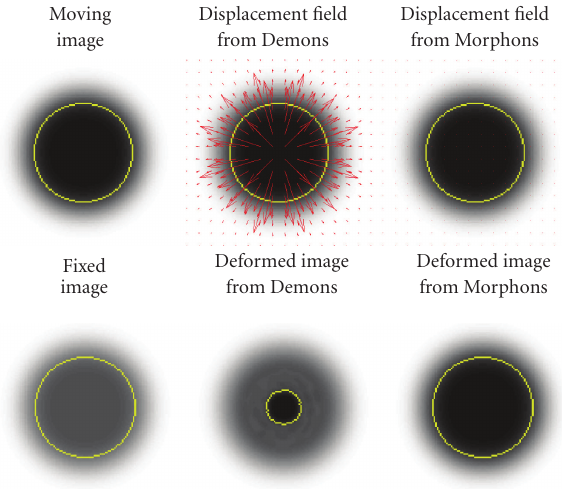
Figure 4: Results of the registration between 2 identical-sized blurred disks with di ff erent contrasts, using Demons and Mor- phons. In yellow: the contour of the disk. In red: the vector field resulting from the registration. The displacement field resulting from Morphons was very close to zero. Notice that the SSD is actually lower using Demons than Morphons. However, the SSD does not reflect the matching of the shapes, in opposition to the disk contour after